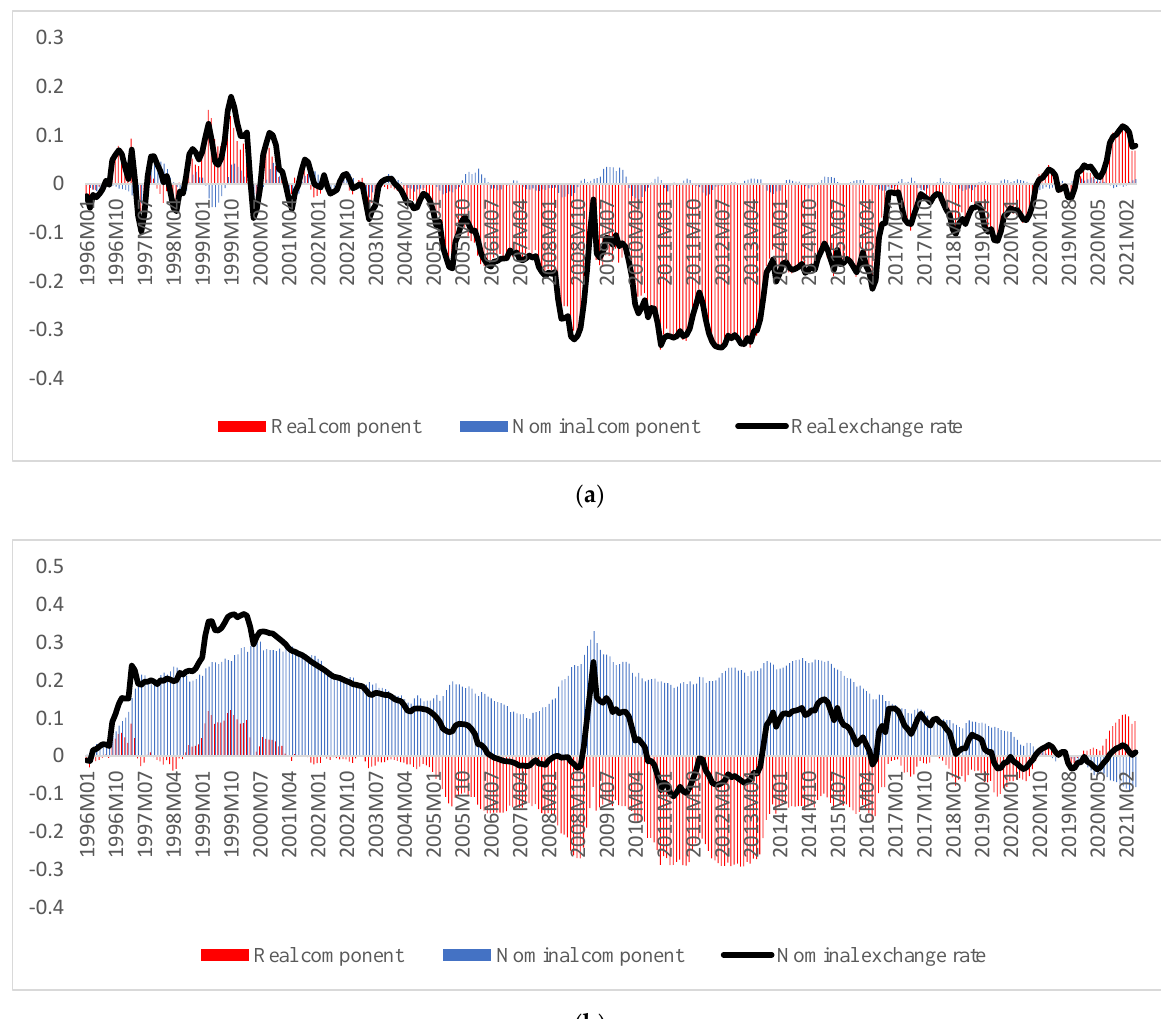
Figure 4. Accumulated historical decomposition of real and nominal exchange rate. Source: Authors’ estimation. Note: The vertical axis is the log deviation from the forecasted exchange rate based on SVAR model specified in this paper. ( a ) Historical decomposition of real exchange rate; ( b ) historical decomposition of nominal exchange rate.